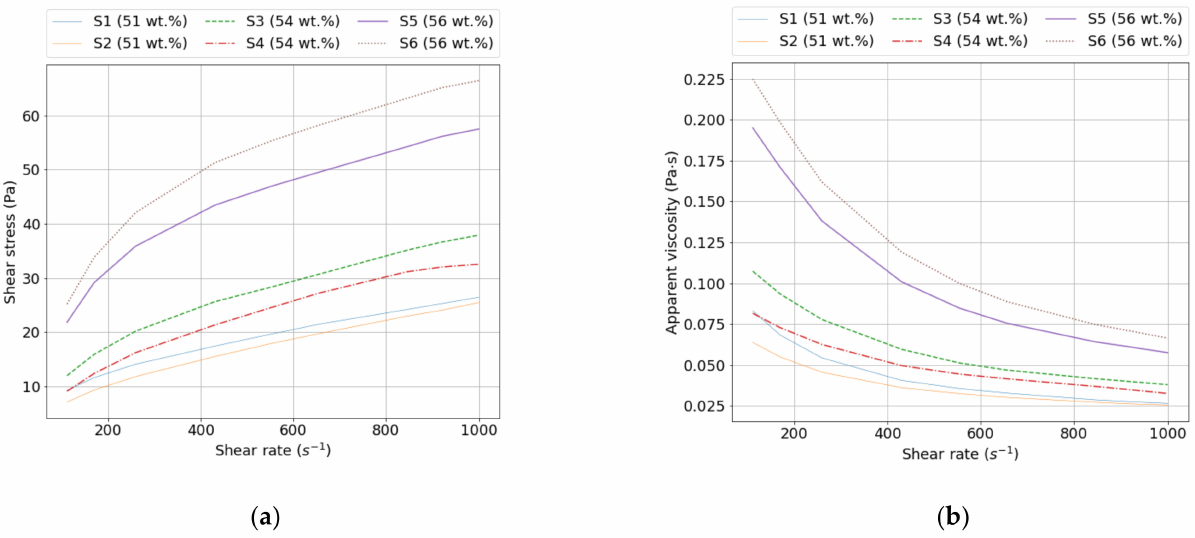
Figure 3. Representative rheograms showing ( a ) the shear stress as a function of the shear rate of CPS samples at various solids concentrations and a fixed temperature of 25 ◦ C and ( b ) the apparent viscosity as a function of the shear rate under the same